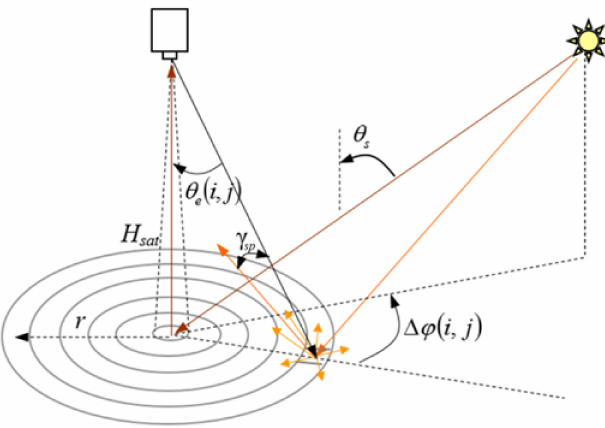
Figure 6. Adjacency effect with a specular component of the reflectance of the environment.